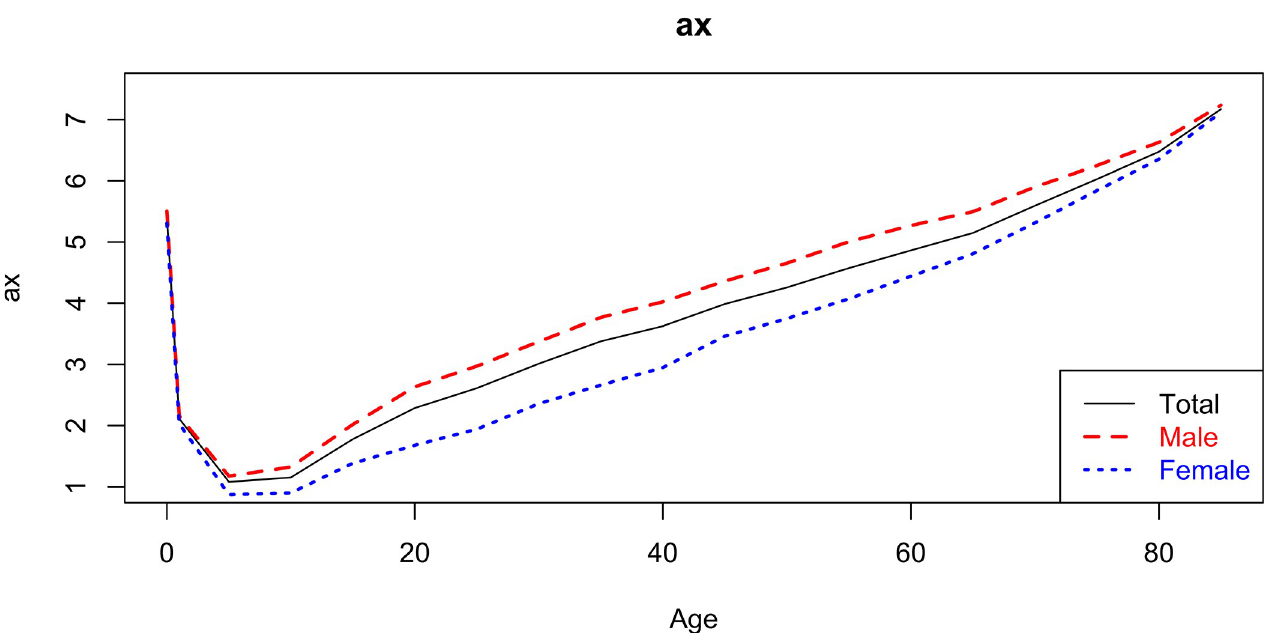
Fig 11. Estimate of ax, from the Lee-Carter model for total and by sex—(2000–2018).